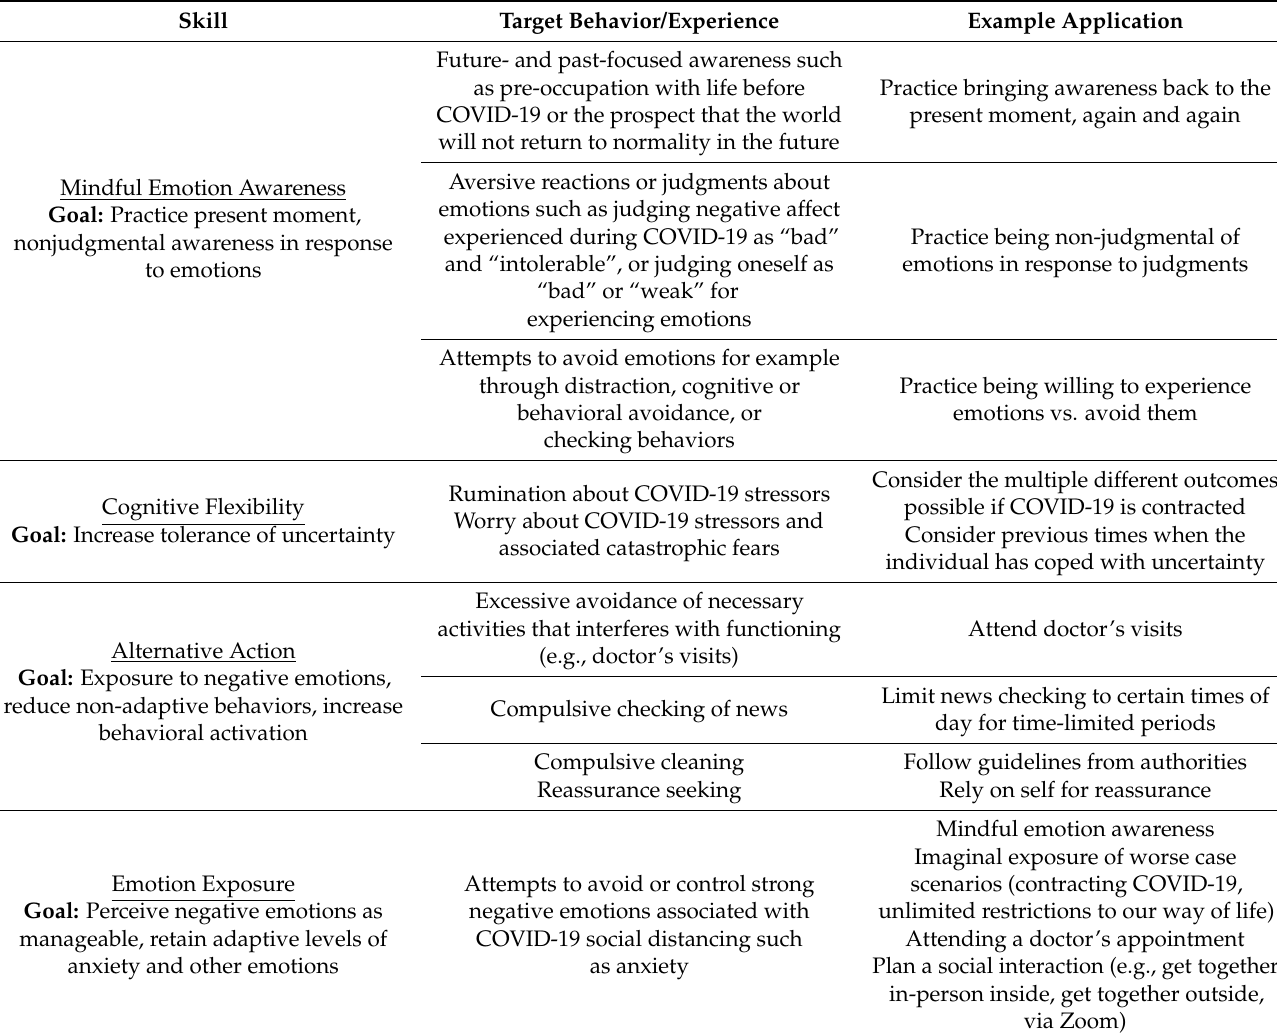
Table 1. Reducing emotion-motivated avoidant coping: techniques from the Unified